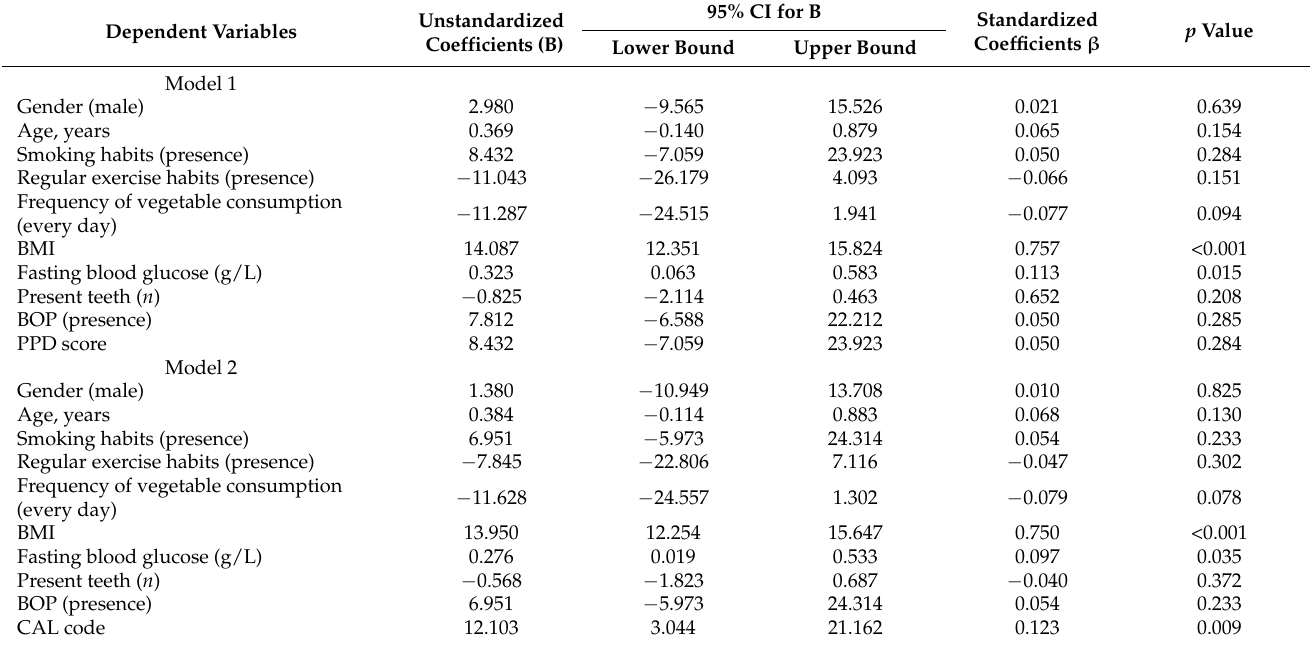
Adjusted R 2 = 0.722 (Model 1) and 0.704 (Model 2). CI; confidence interval, VFA; visceral fat area, BMI; body mass index, BOP; bleeding on probing, PPD; probing pocket depth, CAL; clinical attachment level. Model 1; adjusted gender, age, smoking habits, regular exercise habits, frequency of vegetable consumption, BMI, fasting blood glucose, present teeth, BOP, and PPD score. Model 2; adjusted gender, age, smoking habits, regular exercise habits, frequency of vegetable consumption, BMI, fasting blood glucose, present teeth, BOP, and CAL